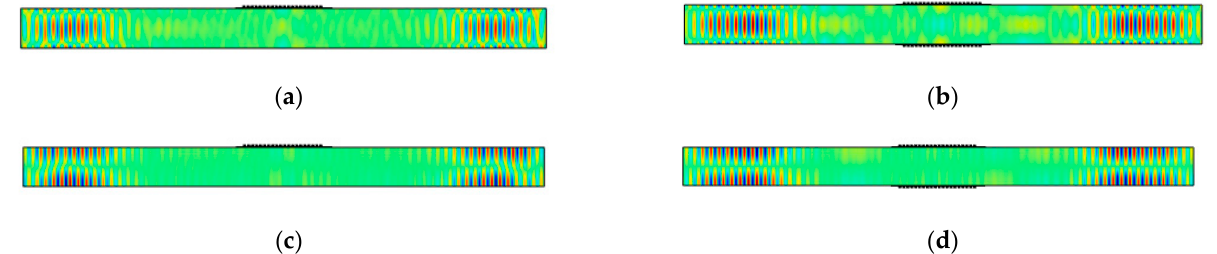
Figure 14. Snapshots at 80 μ s of S0 Lamb wave mode actuation with 520 kHz signal: ( a ) u 1 displacement from single-sided MST; ( b ) u 1 displacement from double-sided MST in-phase; ( c ) u 3 displacement from single-sided MST; ( d ) u 3 displacement from double-sided MST in-phase. The plots are stretched vertically for clarity.